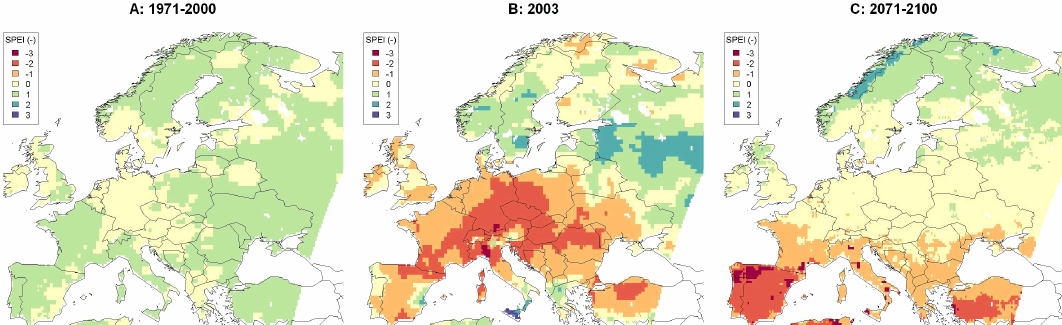
Figure 1. Values of the SPEI drought index across Europe for the months April–September in three different time periods: (a) 1971–2000, (b) the single year 2003, and (c) 2071–2100. Table 1. Average values of model outputs for April–September, averaged over 1971–2000. NPP is net primary productivity (gCm − 2 d − 1 ) , Rh is heterotrophic respiration (gCm − 2 d − 1 ) , NEP is net ecosystem productivity (gCm − 2 d − 1 ) , SWC is soil water content (mm), ET is evapotranspiration (mmd − 1 ) , and n is the number of grid cells simulated. Model Vegetation n NPP Rh NEP SWC ET BASFOR Scots pine 11709 3.33 2.40 0.93 364 1.86 EPIC Winter wheat 5885 2.18 0.69 77 2.15 PASIM Grassland 7756 3.76 0.56 326 1.73 JSBACH Generic 18085 2.93 LPJmL Generic 17785 ORCHIDEE